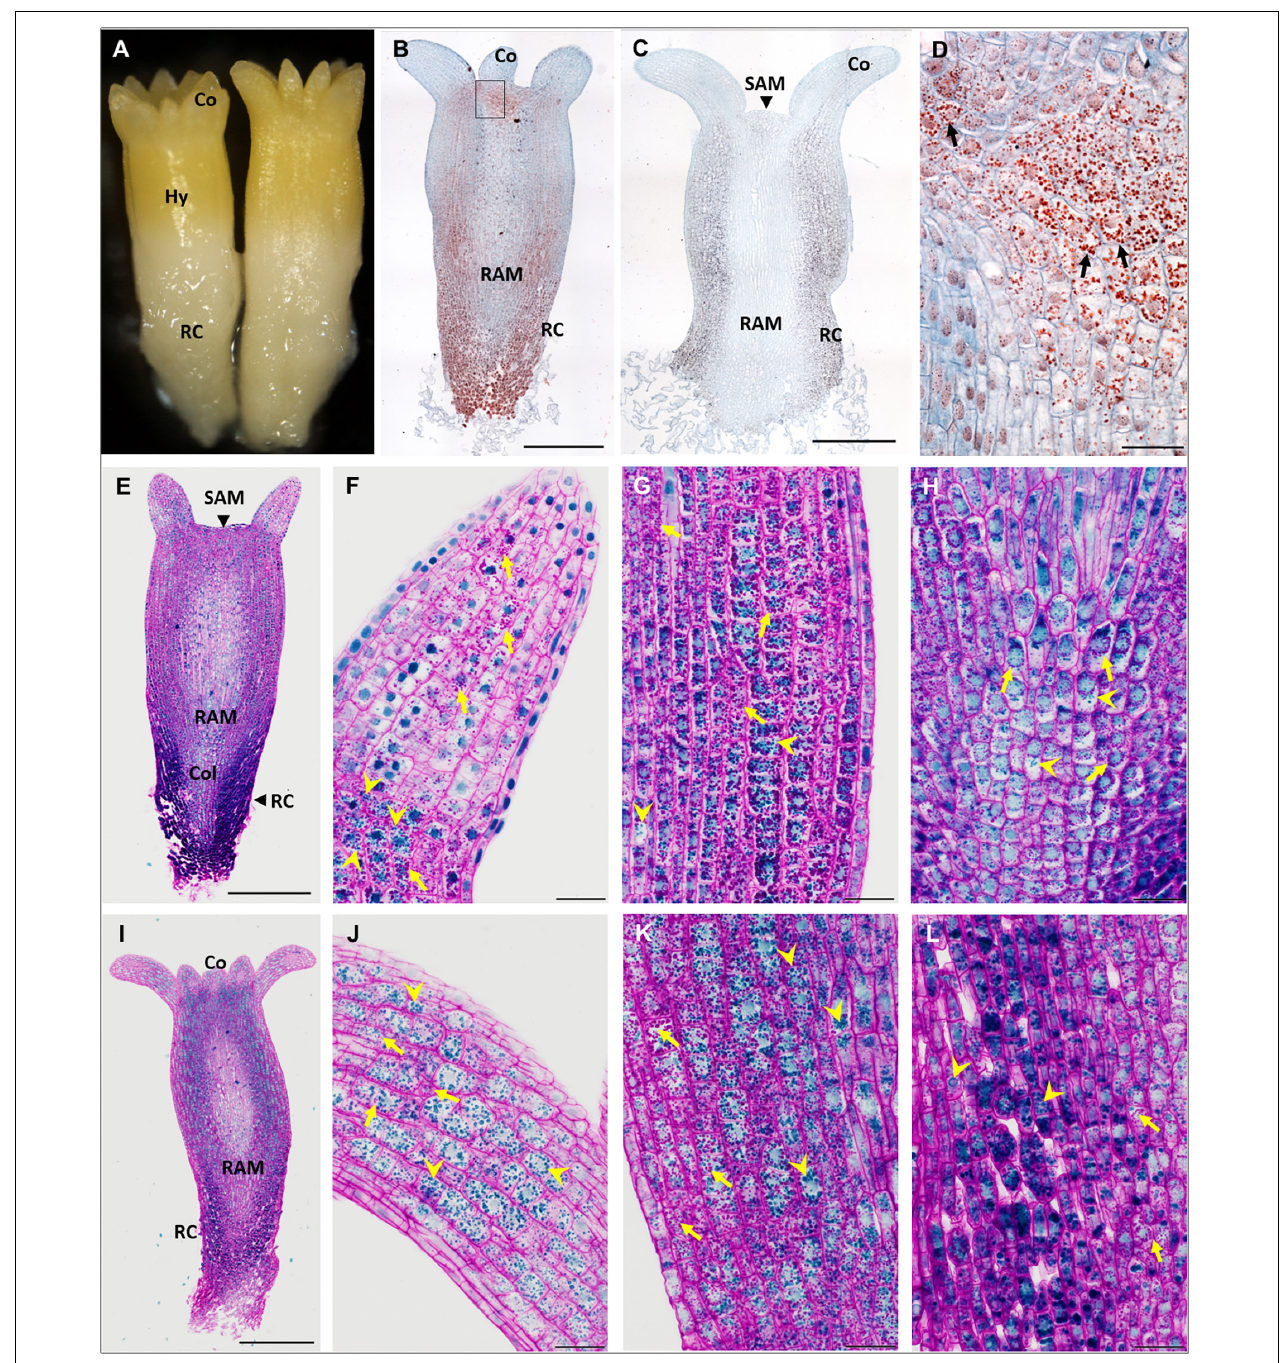
FIGURE 1 | Accumulation of storage compounds in somatic embryos (SEs) of P. abies after five and eight weeks of maturation. (A–H) Five weeks of maturation (M5); (I–L) eight weeks of maturation (M8). (A) Morphology of a M5 embryo. (B) Longitudinal section of a M5 embryo; storage proteins (in red) were detected in protein storage vacuoles (PSVs) using Ponceau xylidine stain, cell walls were counterstained with azure II (in blue); accumulation of PSVs was prominent below the cotyledons and shoot apical meristem and in the root cap. (C) Longitudinal section of a M5 embryo; starch grains were detected using Lugol’s solution (dark points), cell walls were counterstained with azure II; accumulation of starch was prominent mainly in the hypocotyl cortex and root cap, and to a lesser extent under the shoot apical meristem and in the cotyledons. (D) Detail of the zone below the cotyledon, corresponding to the inset in panel (B) , with prominent PSVs (arrows). (E) Longitudinal section of a M5 embryo stained with PAS/amido black (polysaccharides stained magenta in cell walls and starch grains, proteins stained blue in nuclei and PSVs); accumulation of storage proteins was marked in the root cap cells. (F) Detail of a cotyledon in panel (E) with the predominant accumulation of starch grains (arrows); PSVs accumulated at the bottom of the cotyledon (arrowheads). (G) Detail of the hypocotyl cortex in panel (E) , where starch grains (arrows)